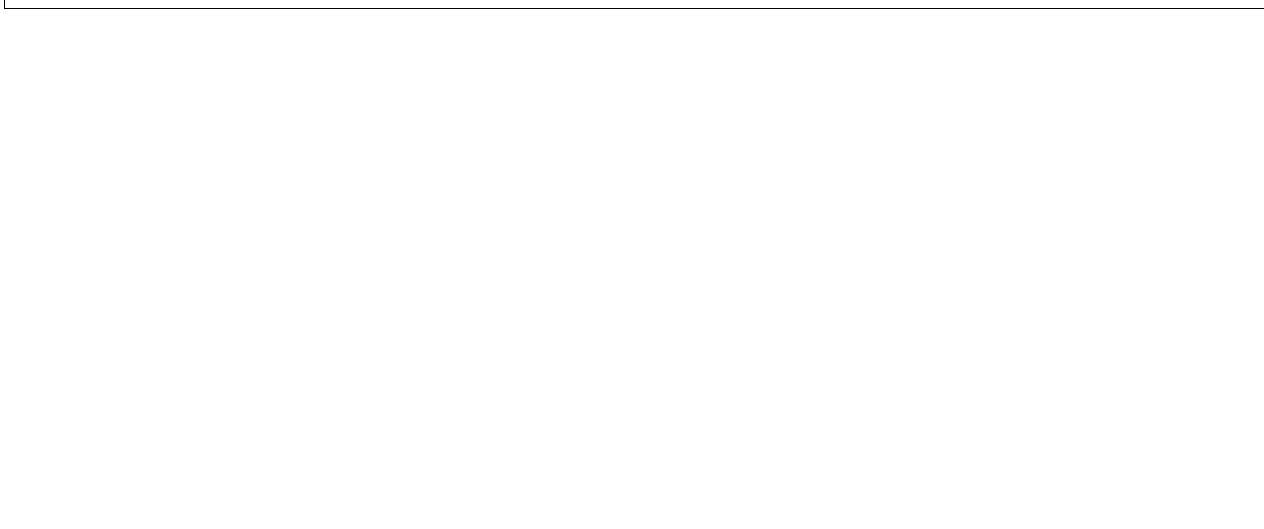
FIGURE 9 | Example of the web interface generated to display global litter paths per